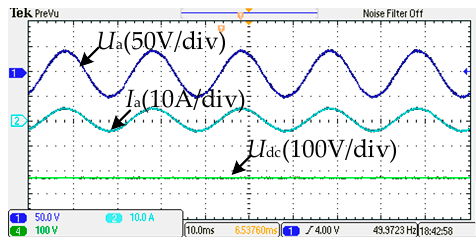
Figure 19. Voltage, current, and DC voltage under normal conditions.